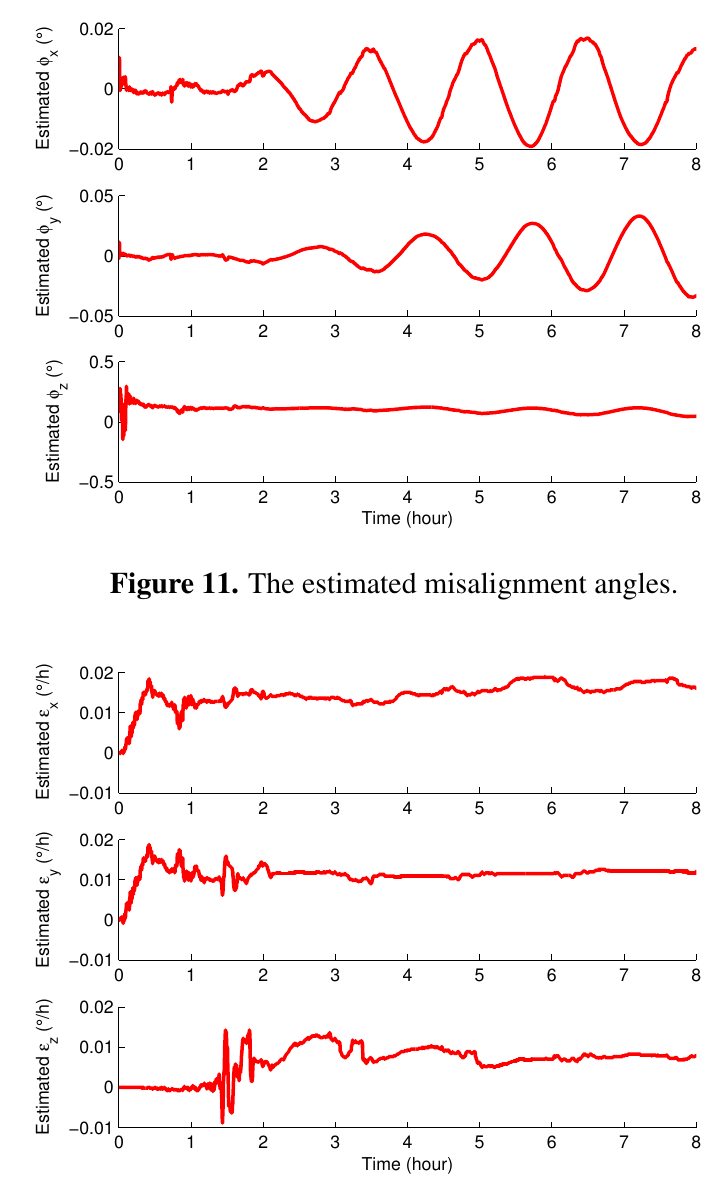
Figure 12. The estimated gyroscope